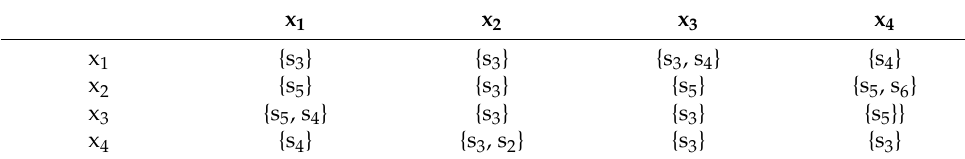
Table 3. The HFLPR given by expert e 3